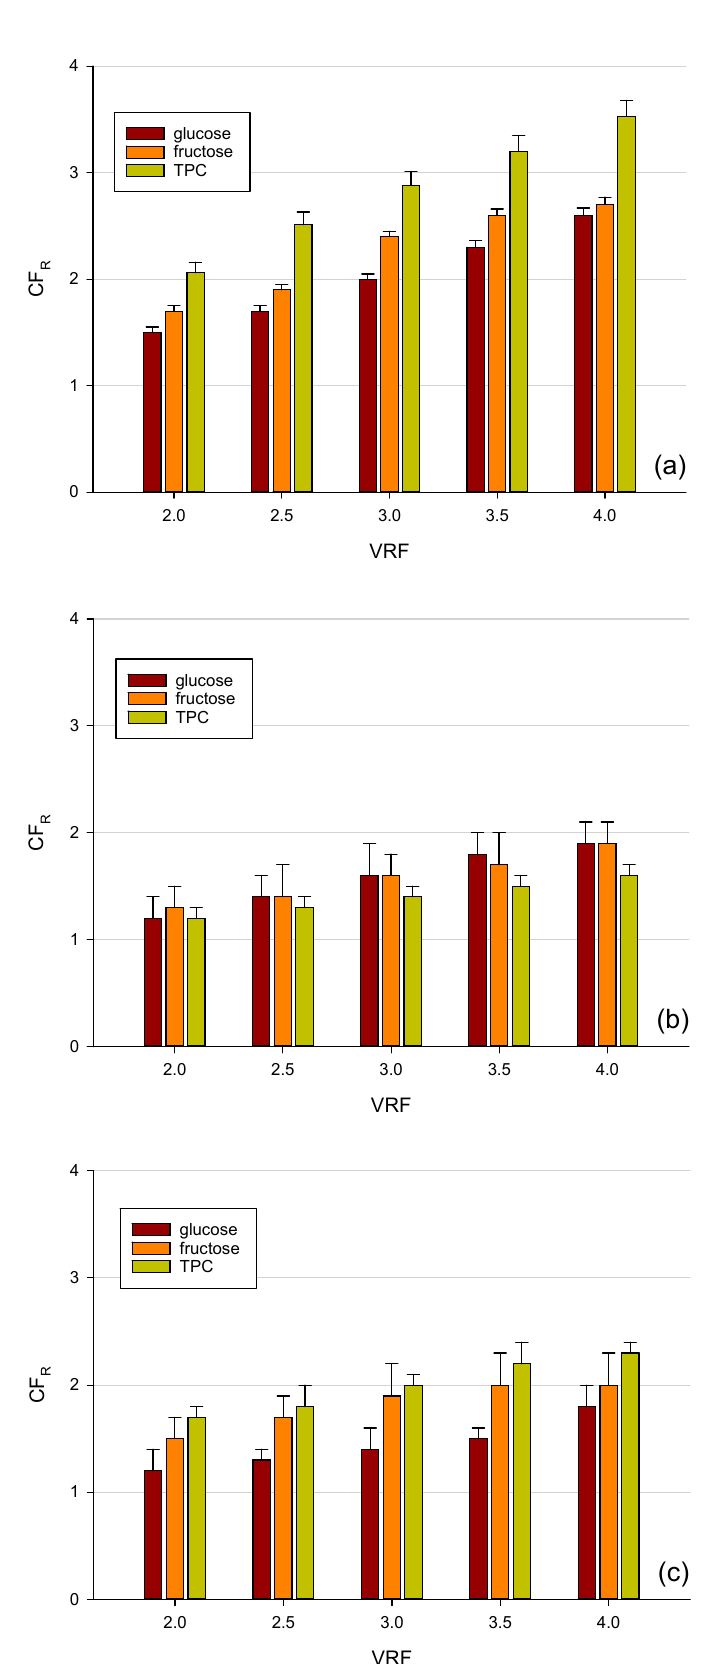
Figure 5. Concentration factor of total phenolic compounds, glucose, and fructose in the retentate stream during the concentration with ( a ) TS40 ( b ) NP030 and ( c ) XN45 membranes. For all selected membranes, the retention level was relatively high when compared with the molecular weight of glucose (180.1559 g/mol) and fructose (180.16 g/mol). These